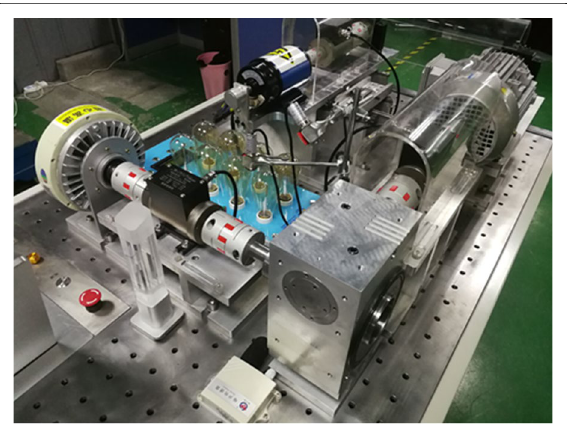
Figure 11 Experimental platform of temperature